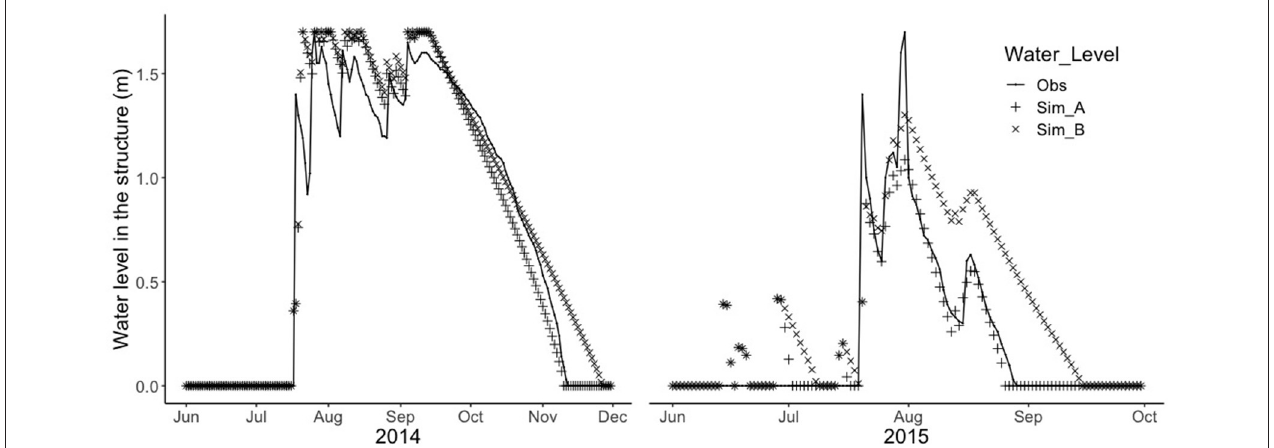
FIGURE 9 | Model validation using data from Dashora et al. (2018): observed and simulated check dam water levels for the years 2014 and